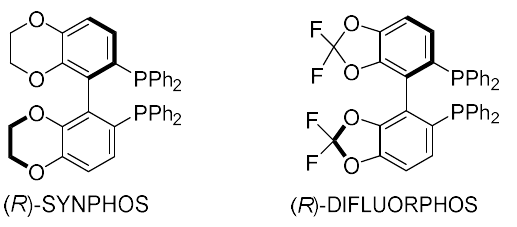
Figure 1. SYNPHOS and DIFLUORPHOS developed in the group.